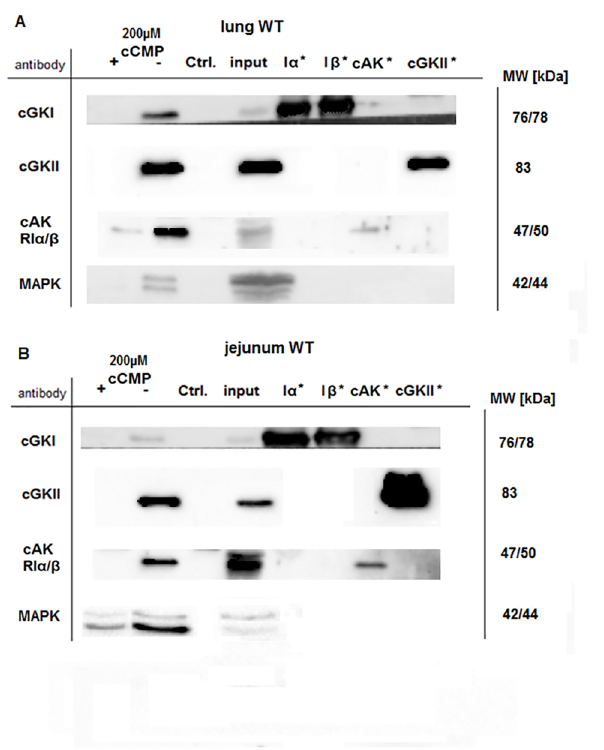
Fig 4. Identification of cCMP-binding proteins (A) Lung tissue lysate (WT) was incubated with 4-AH- cCMP agarose beads or EtOH-NH-agarose beads (ctrl). For the competition experiments, cCMP (200 μ M) was added (+) or omitted (-) as described in the Material and Methods. cCMP-binding proteins were analyzed by electrophoresis and immunoblotting with antibodies directed against cGKIc, cGKII, cAKRI α / β or MAPK. Untreated tissue lysate (1 μ g/ μ L, indicated with input) and purified enzyme (1.5 ng/ μ L) were used as the controls. Purified enzymes are designated with * (B) Same panel as (A) using jejunum (WT) lysate. (S2 Fig) Same experiment depicted in Fig 4 using +/- 2 mM cCMP for competition (WT tissue